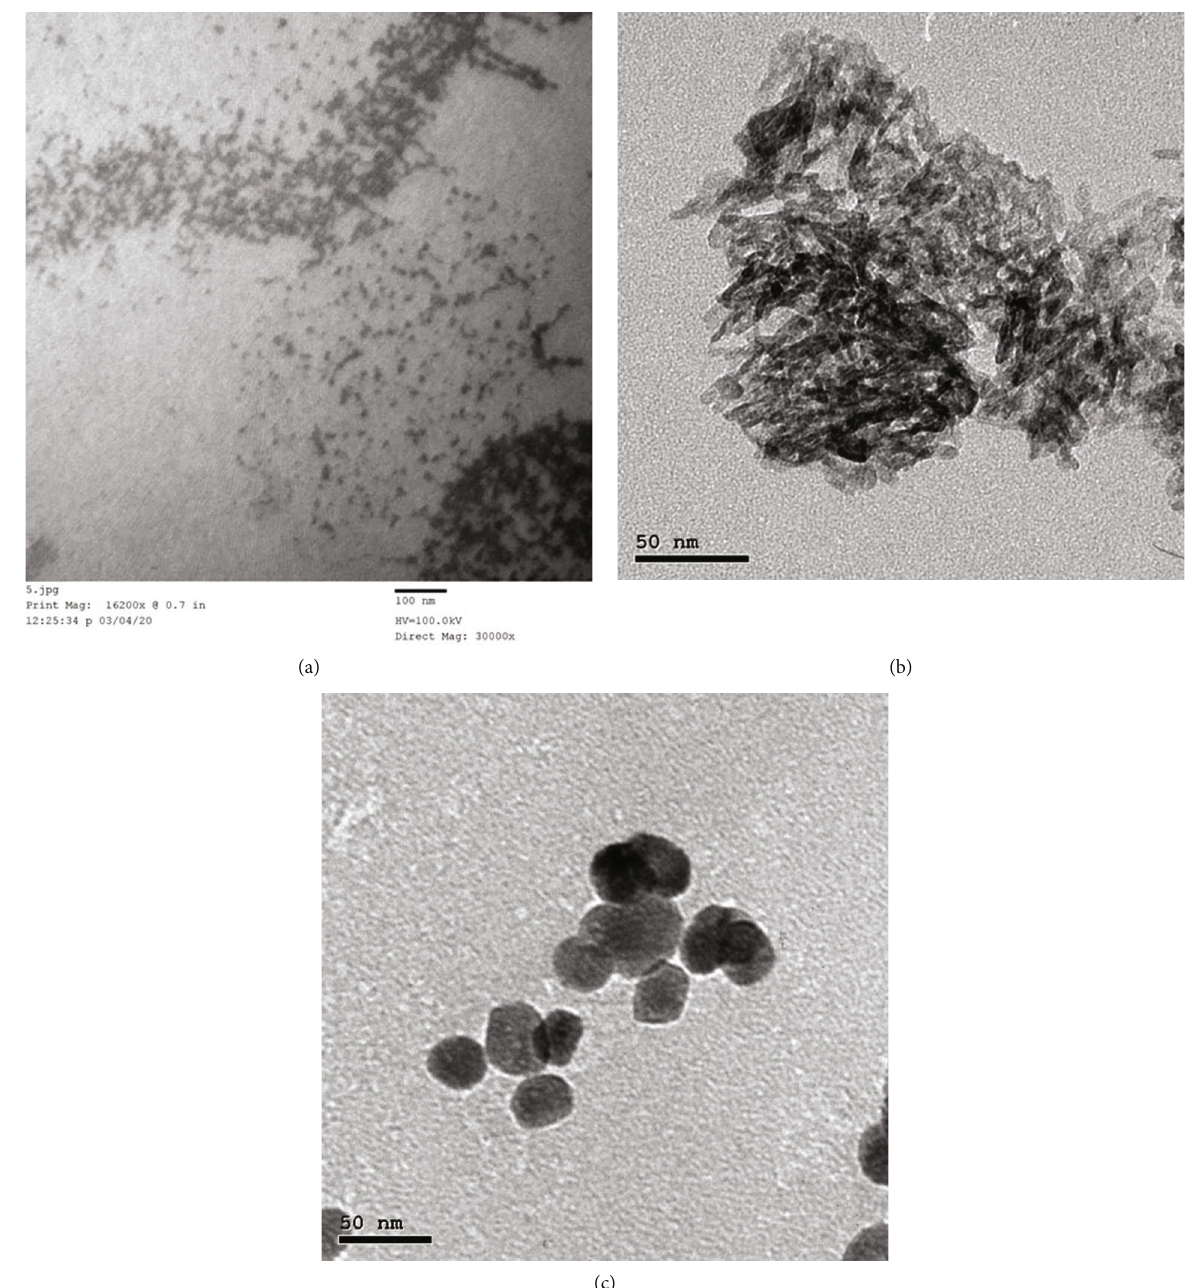
Figure 1: Transmission electron microscope (TEM) images of silica nanoparticles (SiO2NPs) (a), alumina nanoparticles (Al and zinc oxide nanoparticles (ZnONPs)